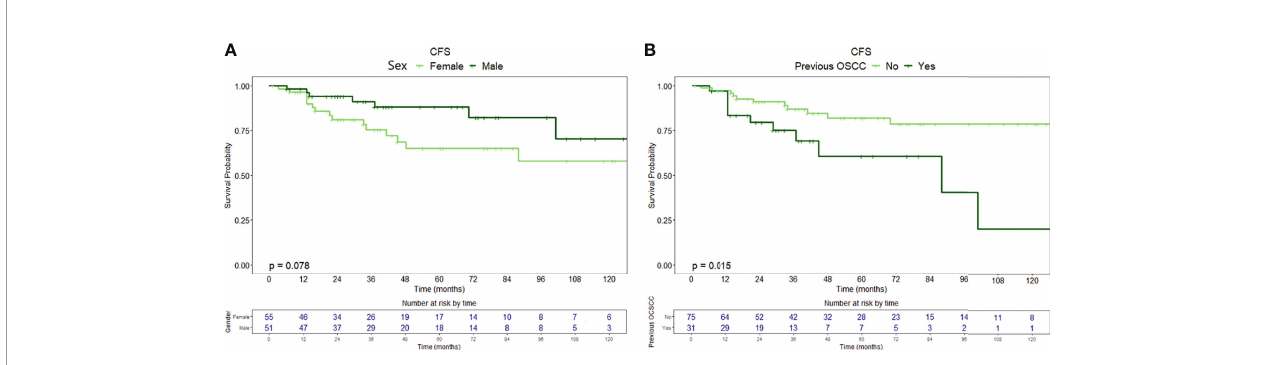
FIGURE 3 | Carcinoma-free survival curves with relative tables of patients (whole population) at risk according to (A) sex and (B) history of previous OSCC.